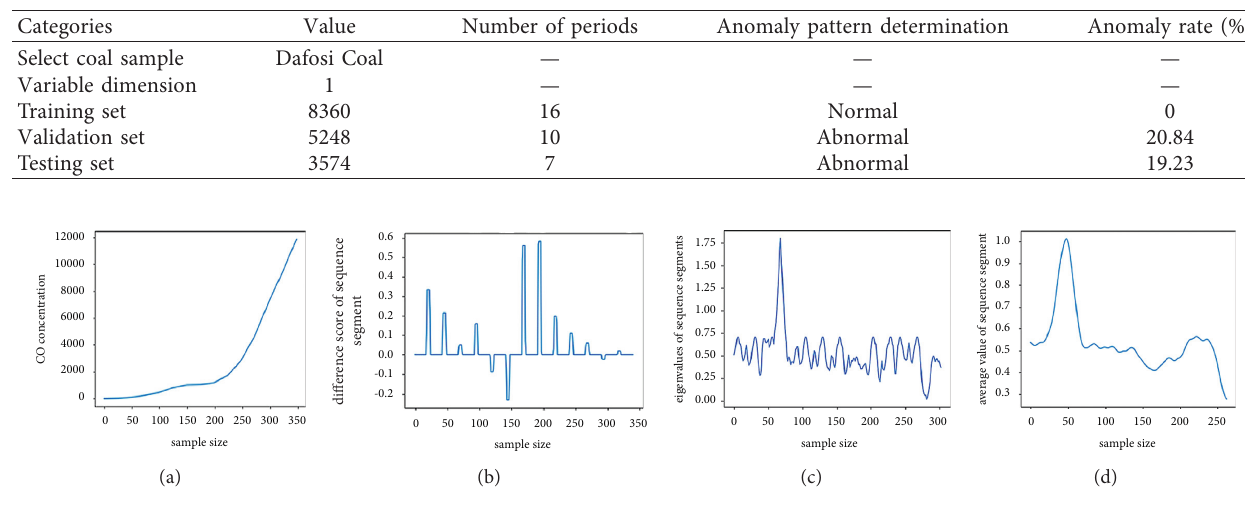
Table 3: Description of experimental data.